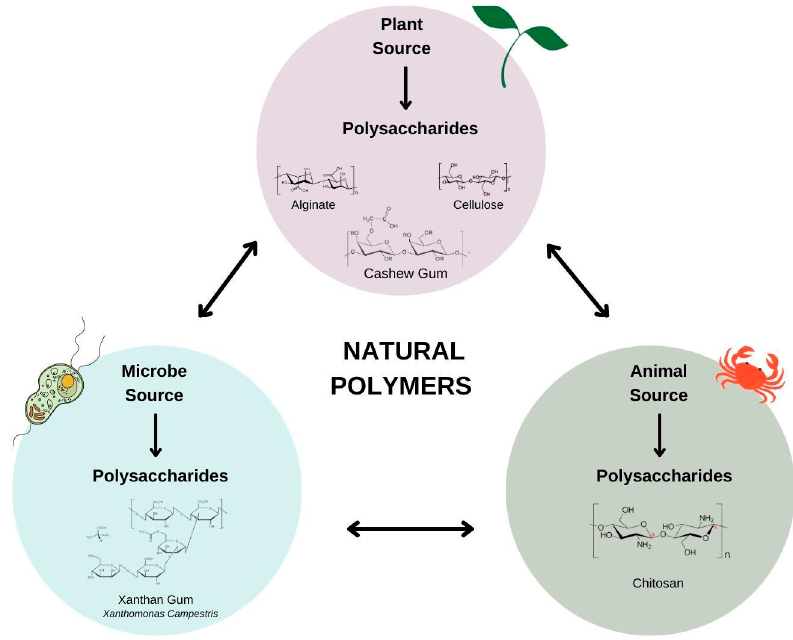
Figure 1. Natural polysaccharides based on sources.